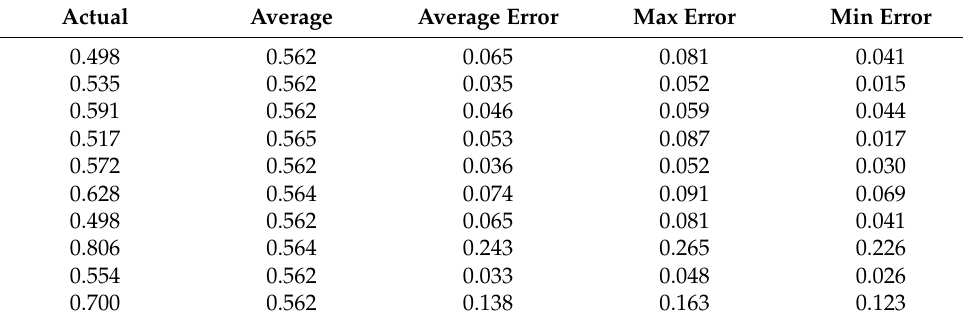
Table A201. Set 3, trials 31–40 data (single 0.5 PR value).